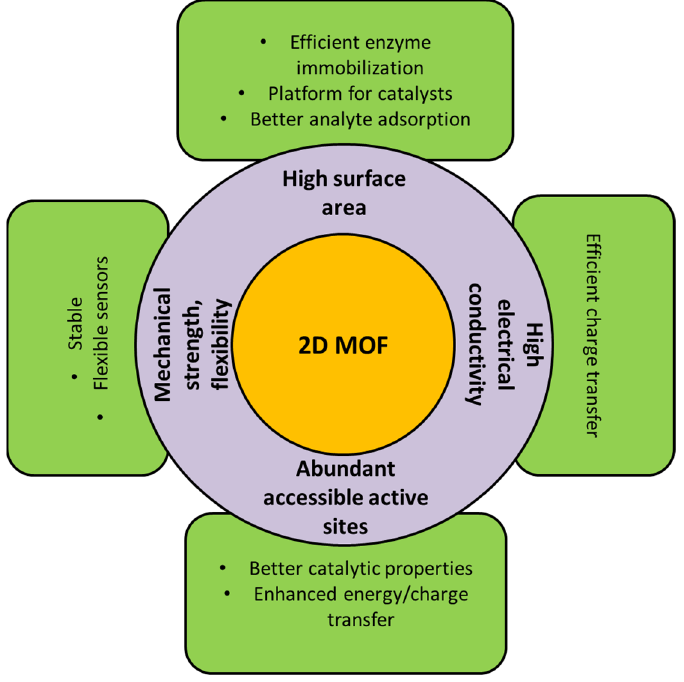
Figure 2. Diagram depicting the properties of 2D MOFs that makes it interesting for sensor applications.